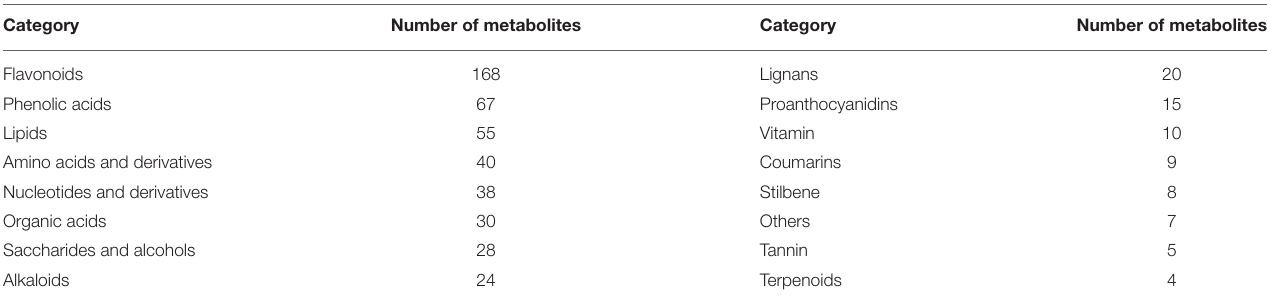
TABLE 2 | Categories of the 528 metabolites identified in five tissues of P. taeda